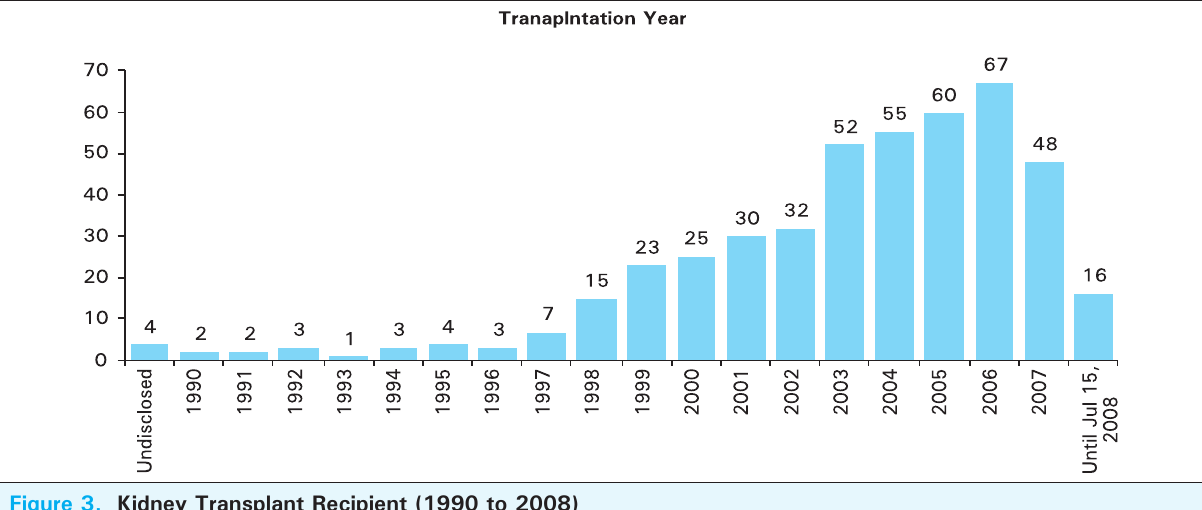
Figure 3. Kidney Transplant Recipient (1990 to